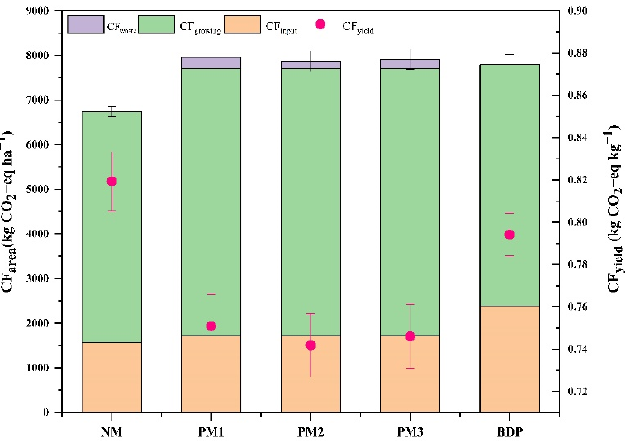
Figure 4. The CF input , CF growing , CF waste and CF yield in NM, PM and BDP cultivation systems. (PM1, PM2 and PM3 represent PE film waste was treated by incineration, landfill and recycling, respec ‐ tively).